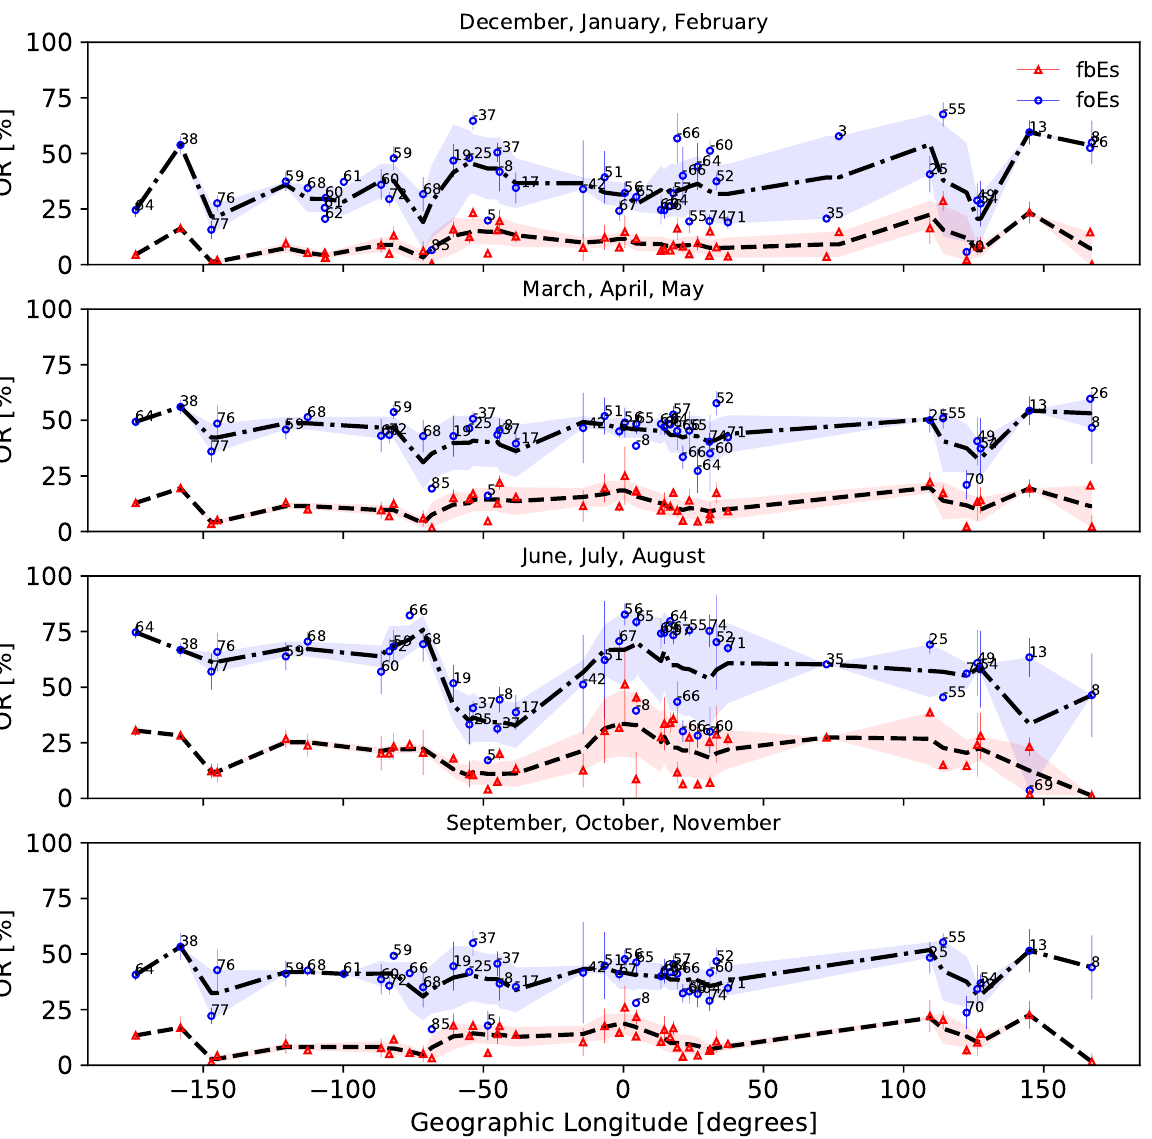
Figure 6. Occurrence rates for fbEs and foEs without a lower limit on intensity separated by geographic longitude. Error bars correspond to the standard deviation of the yearly averages taken over all years with sufficient data. The trend lines and shading correspond to spatial running averages and standard deviations calculated with a ± 10 ◦ window, respectively. Annotated numbers next to the foEs points correspond to the geomagnetic